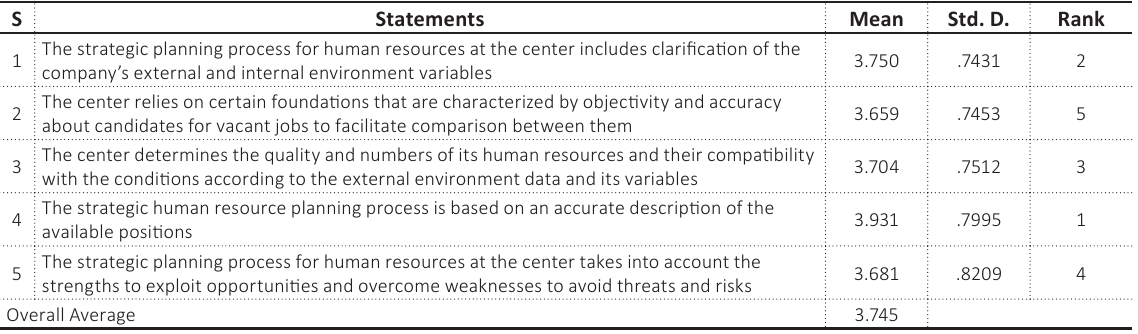
Table 1. Means and standard deviations of the environmental analysis variable S